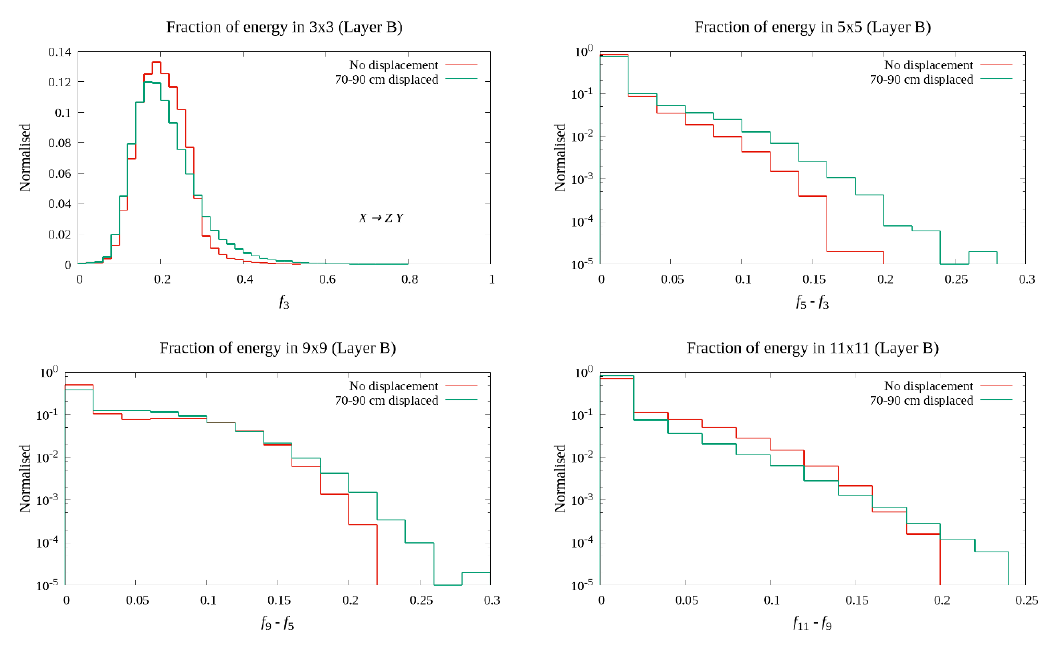
Figure 16. Normalised distributions of energy deposition fraction ( f i ) with varying sizes of blocks ( i (cid:2) i ) for the non-displaced and 70{90 cm displaced Z boson in layer B.